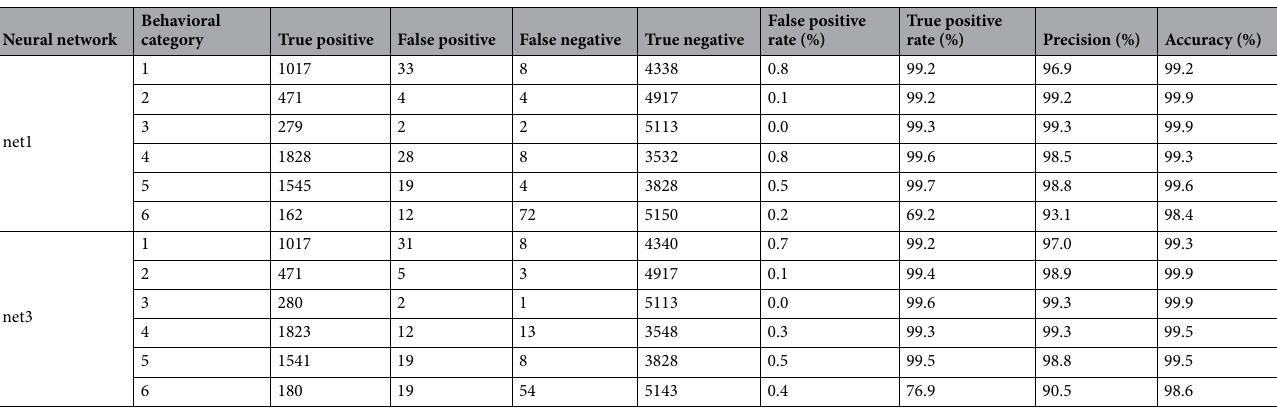
Table 2. Common performance metrics calculated from confusion